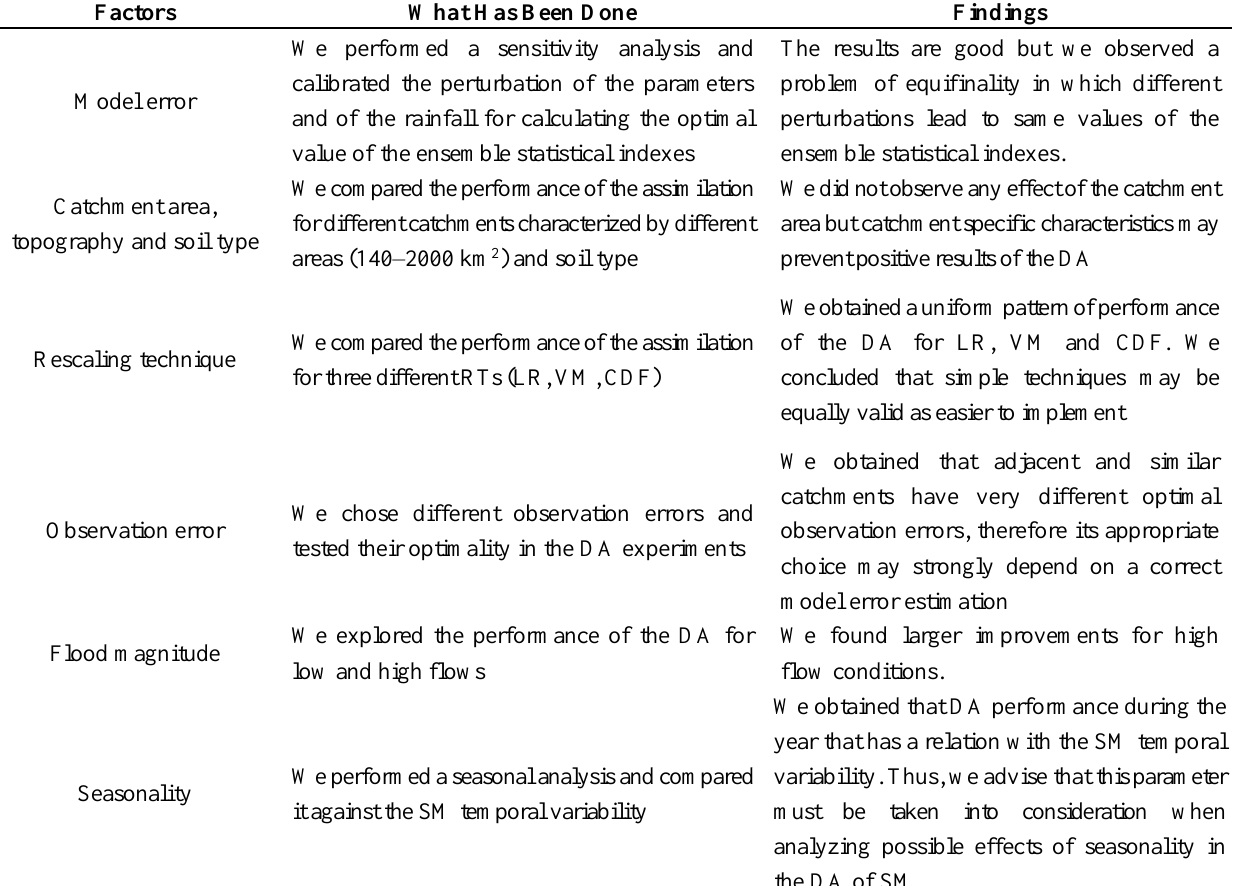
Table 4. Analyzed factors and findings in the DA of soil moisture in Central